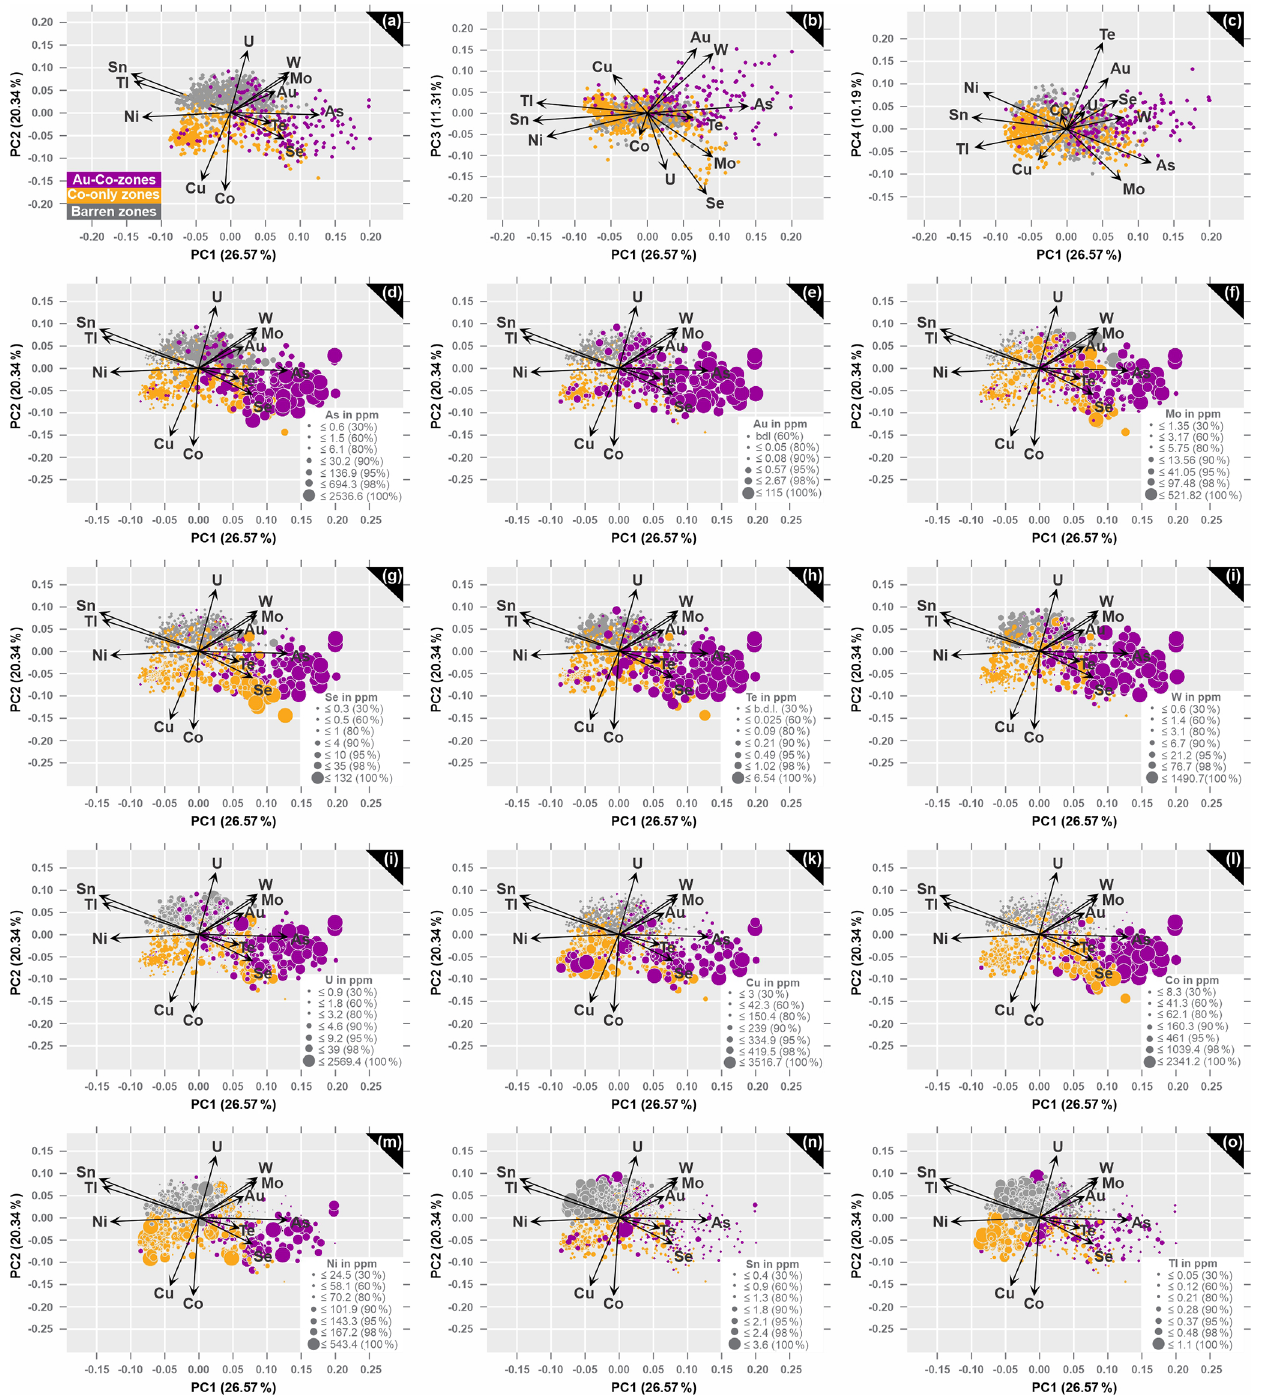
Figure 9. Principal component loadings (arrows) and scores (observations) of clr transformed n = 1084 data. Biplots illustrate the projections of the first four principal components: (a) PC1 versus PC2 (48.6% of the data variability), (b) PC1 versus PC3 (37.9% of the data variability) and (c) PC1 versus PC4 (36.8% of the data variability). PC1–PC2 projection in correlation with concentrations of (d) As, (e) Au, (f) Mo, (g) Se, (h) Te, (i) W, (j) U, (k) Cu, (l) Co, (m) Ni, (n) Sn, and (o) Tl.